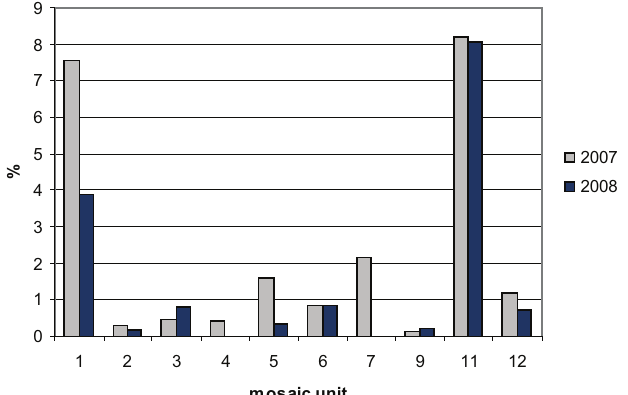
Figure 7. Percental h S area from total area in the mosaics covering northern Russia. For W location see Figure